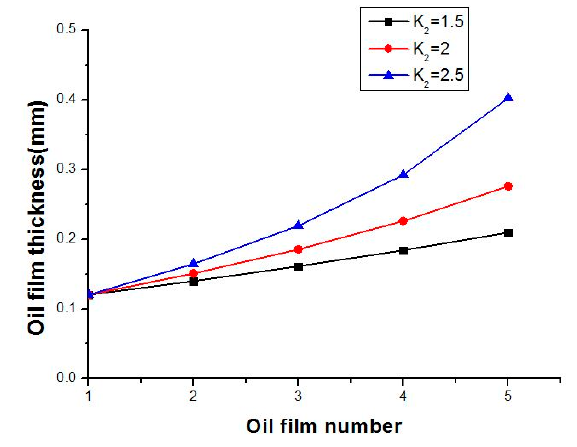
Figure 6. Oil film thickness distribution with different K 2 .